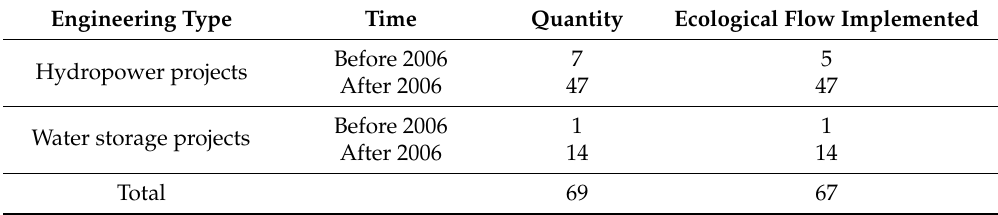
Table 3. Water storage and hydropower projects of ecological flow implementation.